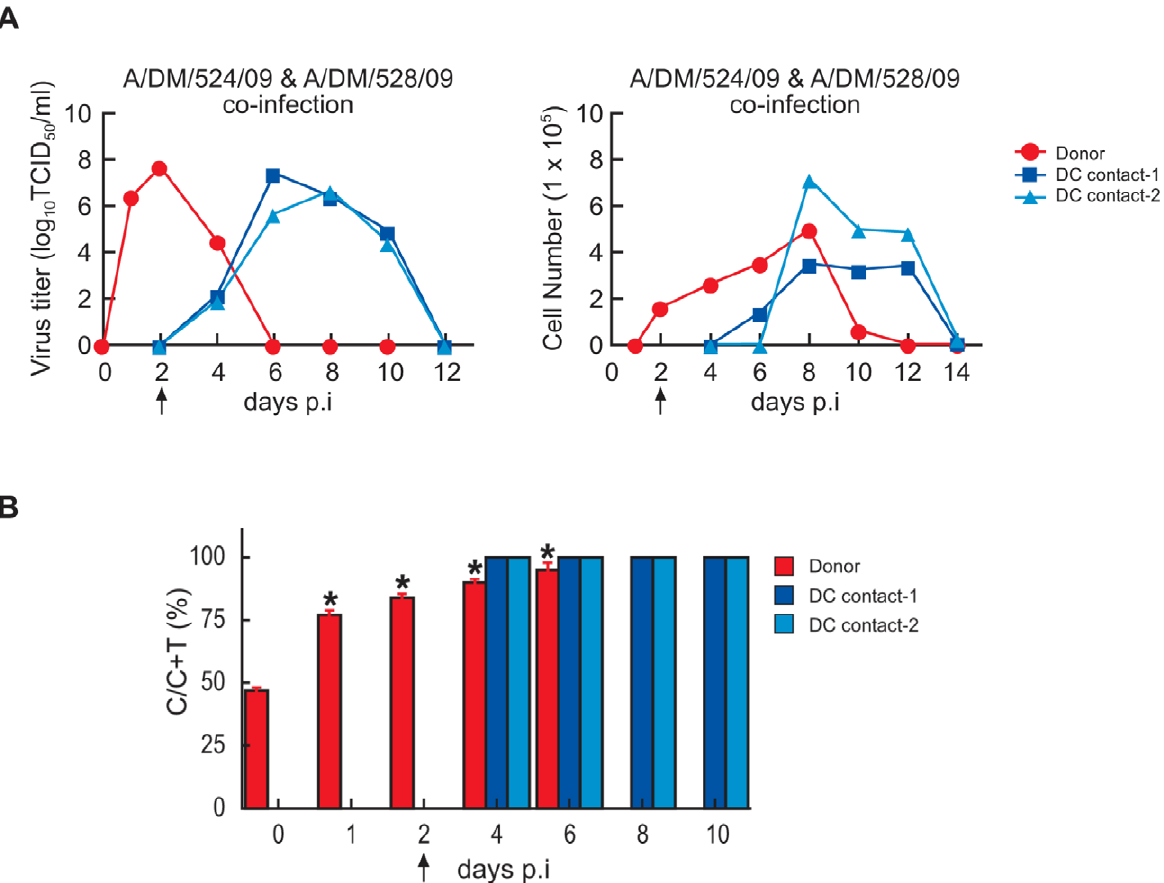
H1N1 virus Direct contact Respiratory droplets exposure Clinical signs Virus detection Clinical signs Virus detection Weight Virus loss a shedding c